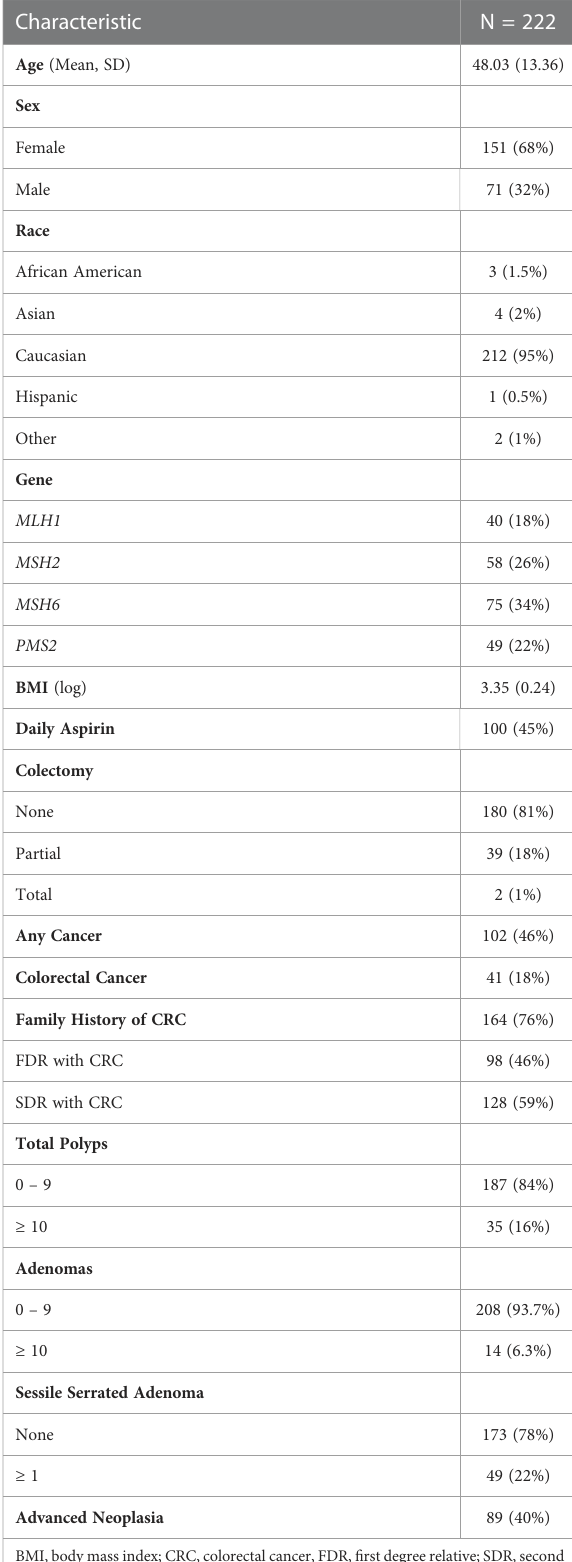
TABLE 1 Characteristics of patients with Lynch